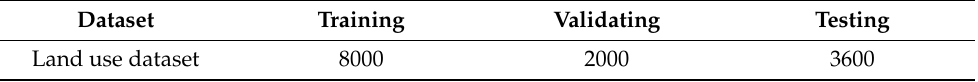
Table 1. The number of samples for training, validating, and testing from the land use dataset. Figure 2. Sample sets of land use dataset showing the different spectral reflectance from Band 1 to Band 7 and labelled imagery. Dataset